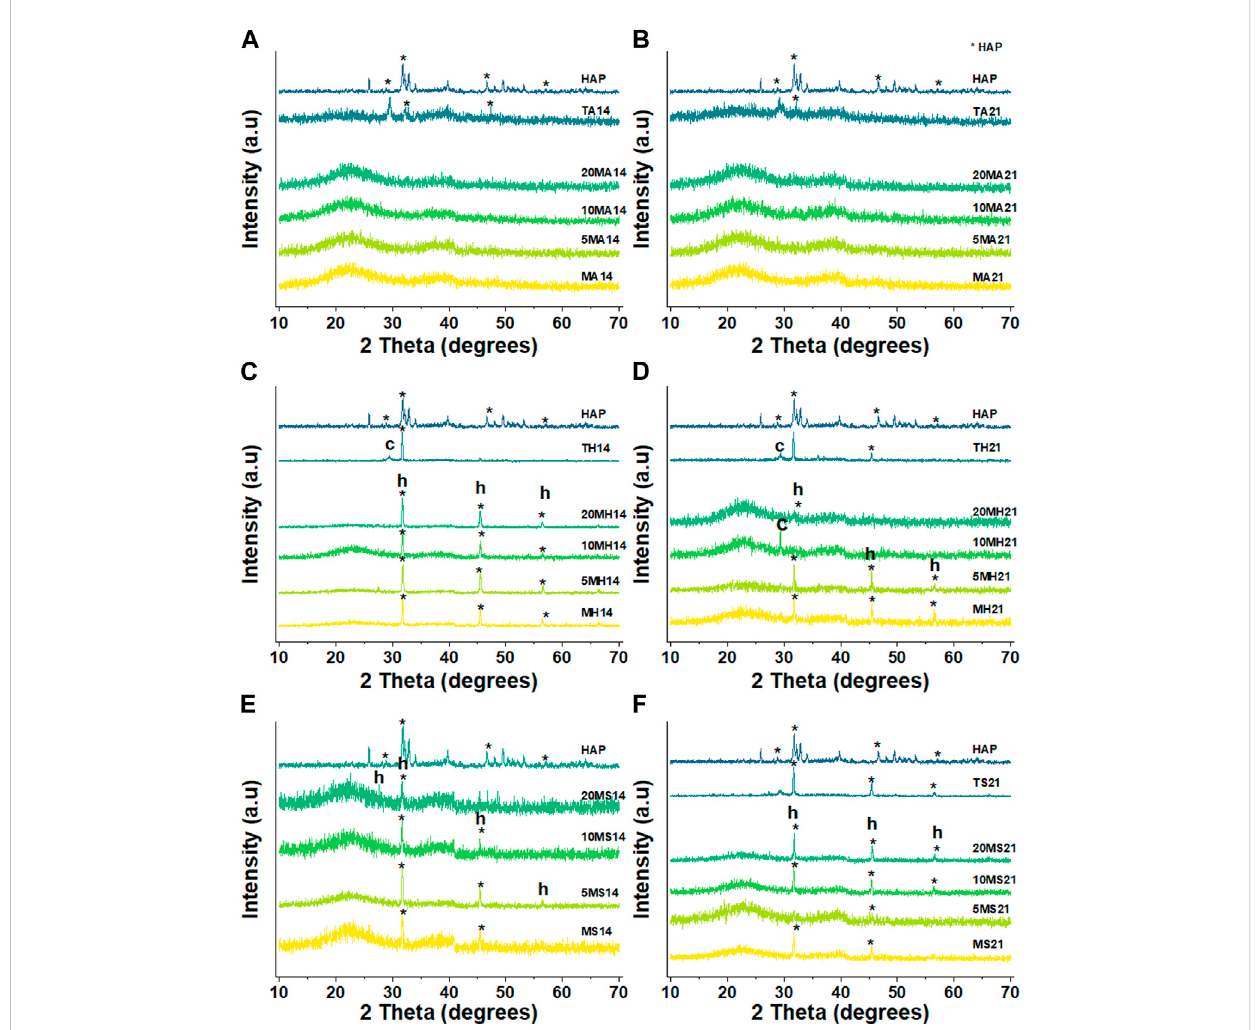
FIGURE 8 XRDpatternsoftheparticlesunderinvestigationfollowing14 daysand21 dayaysimmersioninAS (AandB) ,HBSS (CandD) andSBF (EandF) where * refers to the HAP, h represents halite, and c refers to